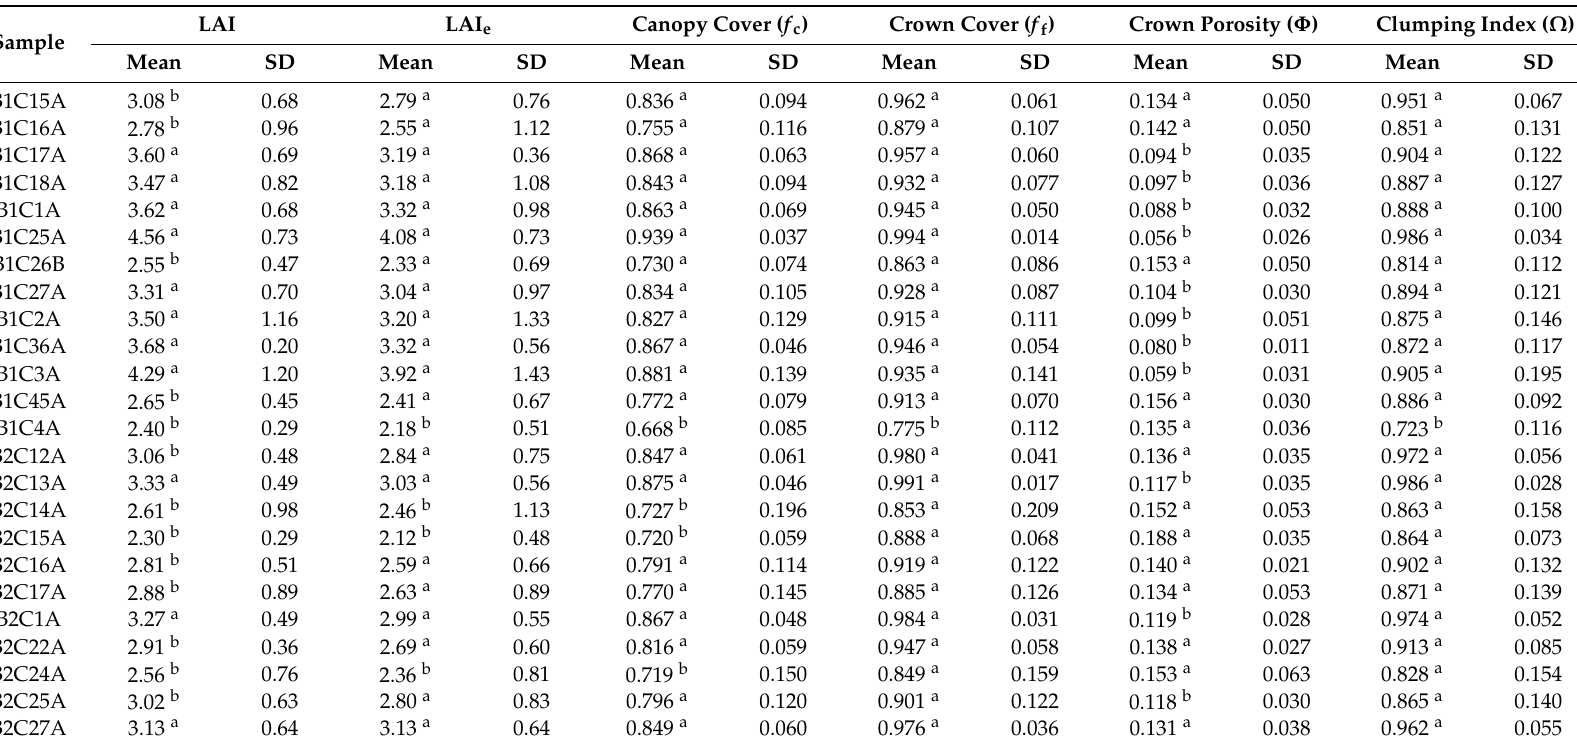
Table 1. Means and standard deviation (SD) of the parameters obtained from the canopy architecture for each sampled tree. Di ff erent letters (superscripts) represent statistically significant di ff erences between samples using the Tukey studentized test with α = 0.05.